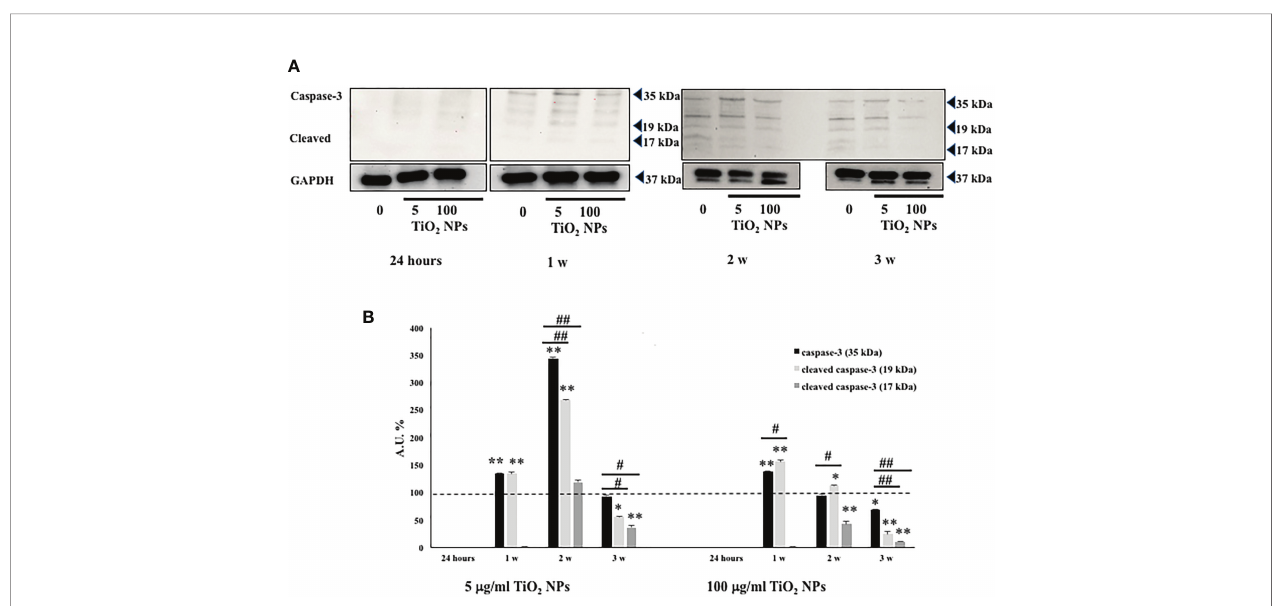
FIGURE 5 | WB analysis. (A) Immunoblots of caspase-3 p35, p19, and p17 in SCs at 24 h and 1, 2, and 3 weeks of incubation with TiO 2 NPs at 5 and 100 µg/ml. (B) Densitometric analysis of the protein bands of caspase-3 p35 (black bar), p19 (light grey bar), and p17 (dark grey bar) in SCs at 24 h and 1, 2, and 3 weeks of incubation with TiO 2 NPs 5 and 100 µg/ml. Data represent the mean ± SEM (* p < 0.05,** p < 0.001 vs. unexposed SCs (black dotted line) and # p < 0.05, ## p < 0.001 vs. p35 of three independent experiments, each performed in